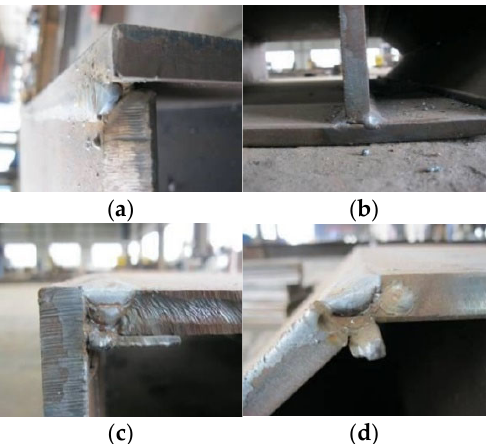
Figure 3. Weld details before casting of concrete. ( a ) Weld detail 1; ( b ) Weld detail 2; ( c ) Weld detail 3; ( d ) Weld detail 4.